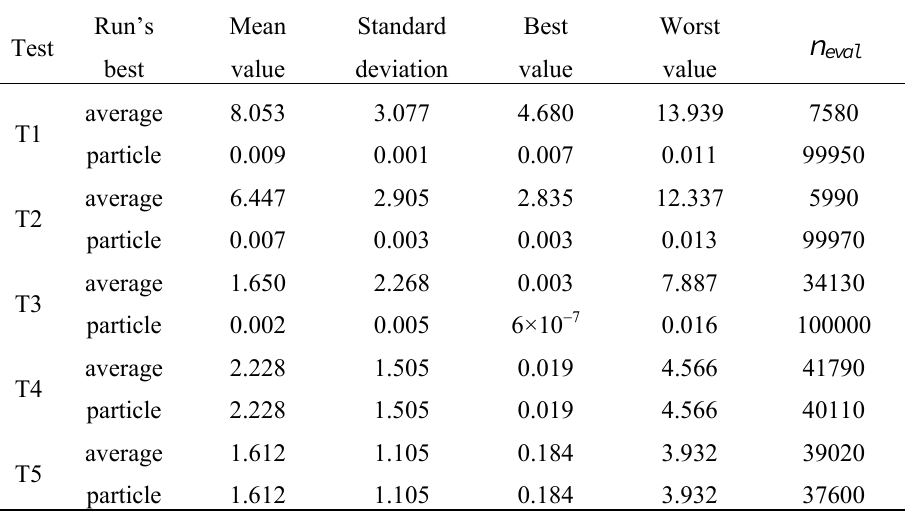
Table 8. Results of the numerical tests on the Rosenbrock’s